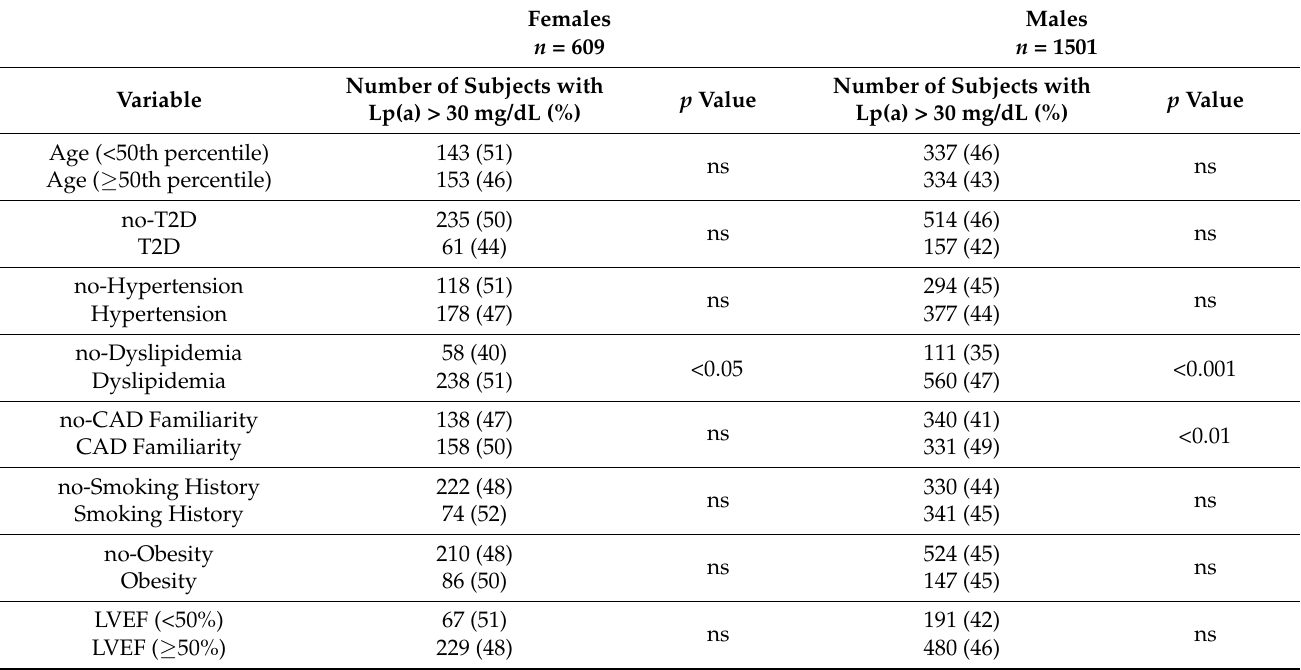
Table 2. Number and percentage of subjects with Lp(a) > 30 mg/dL in female and male patients for each variable